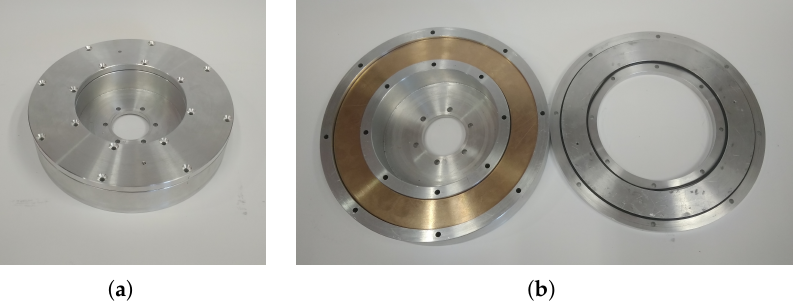
Figure 1. Viscous torsional vibration damper: ( a ) view with the cover closed, ( b )